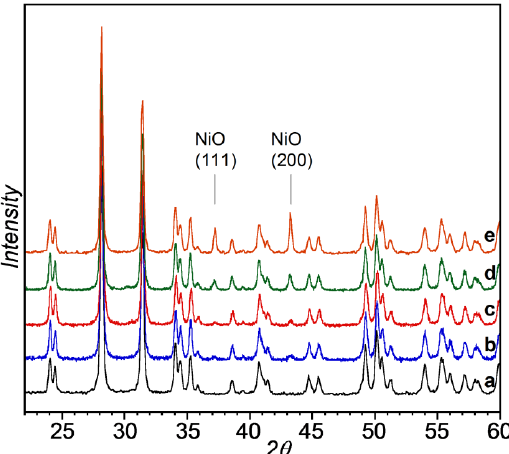
Figure 1. XRD patterns of monoclinic ZrO 2 and NiO/ZrO 2 catalyst precursors. ( a ) Z m ; ( b ) Table 1. Structural and textural features of precursors and catalysts (activated or used): specific surface area (S.A.), total pore volume (V tot ) and crystallite size (d XRD ) of ZrO 2 , NiO and Ni.